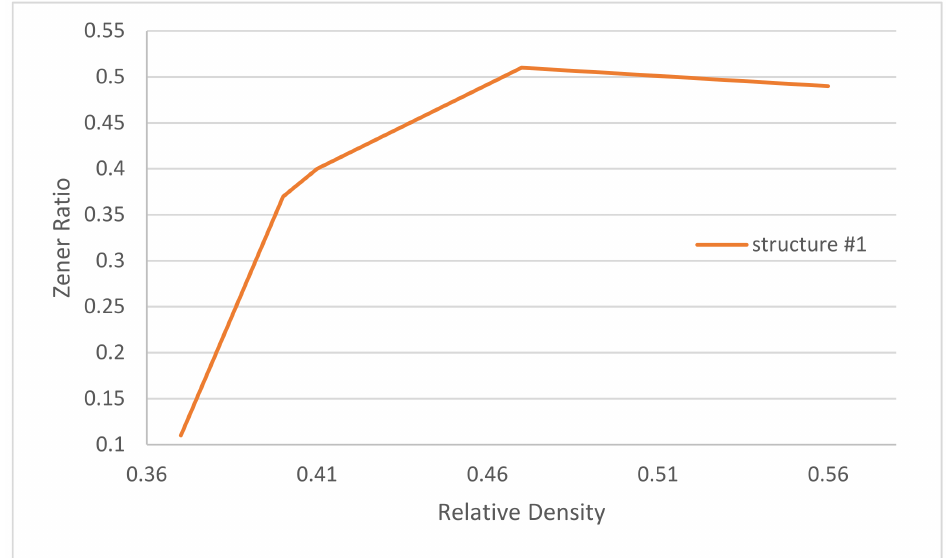
Figure 14. Zener ratio values for different relative densities of structure #1.